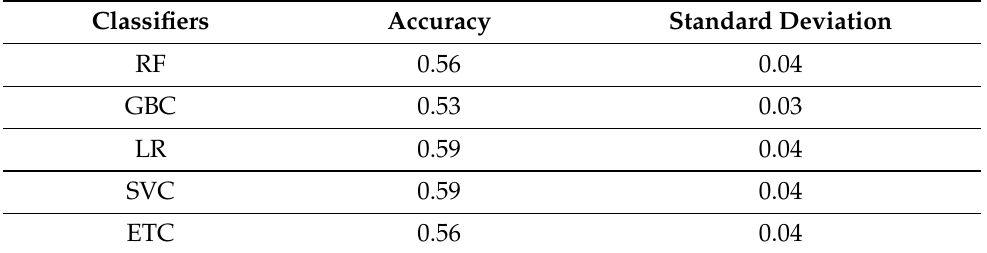
Table 11. 10-fold cross-validation results on LR and SVM features using machine learning